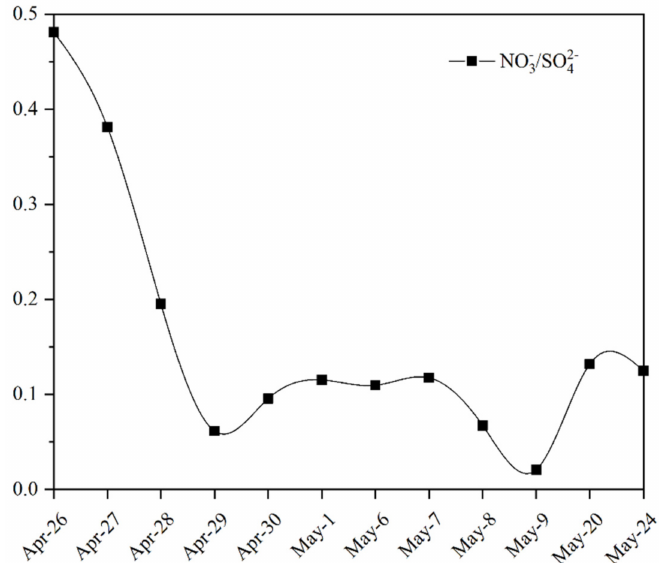
Figure 5. The ratio of the mass concentration of SO 4 2 − to NO 3 − during sampling.